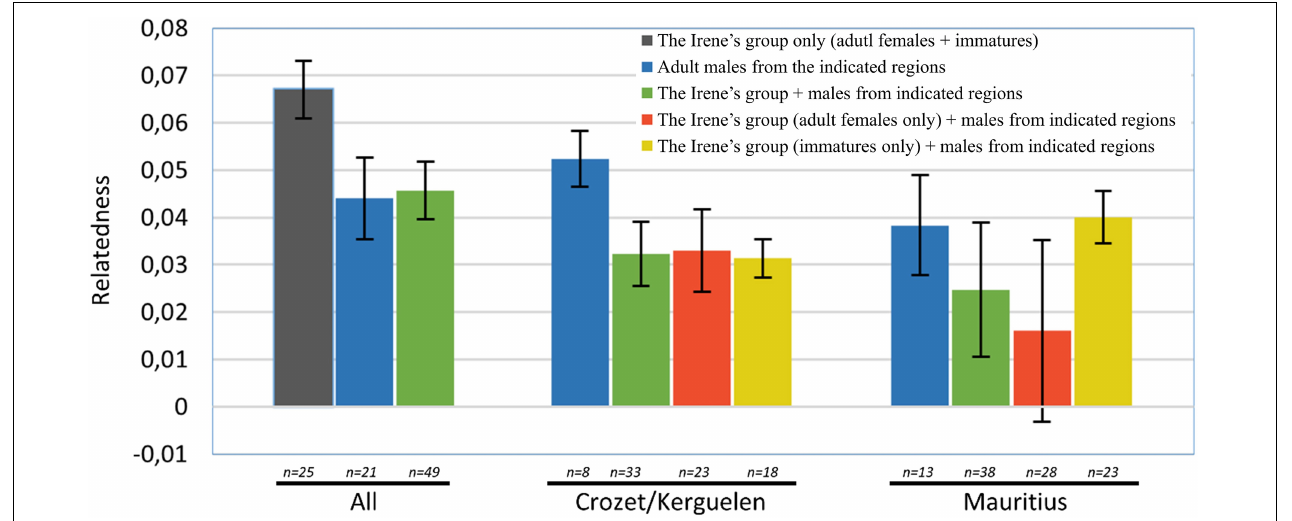
FIGURE 4 | Differences of average relatedness coefficients in groups and subgroups. Relatedness coefficients computed as the average of r k (Kalinowski et al., 2006), r W (Wang, 2002) and r L (Li et al., 1993) calculated through ML Relate and through Relate. The relatedness coefficients are first represented for all members of the Irène’s group, for all adult males and for all individuals. Note that the values of the Irène’s group are the higher (shown in dark gray, see Supplementary Table 8 for detail). Different combinations of individuals were then formed, and the relatedness coefficients calculated. The partitioning of the Irène’s group between adult females and immatures had a strong impact on the r calculated with adult males sampled off Mauritius, but not with those from Crozet/Kerguelen.